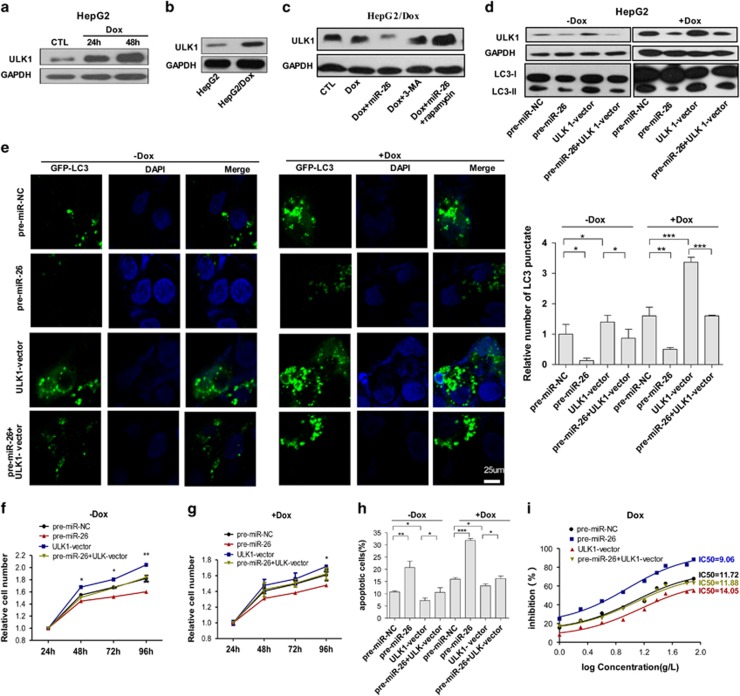
MiR-26a/b enhances the sensitivity of HCC cells to chemotherapeutic drugs and promotes HCC apoptosis by inhibiting autophagy in vitro. (a) Representative western blotting analyses of ULK1 in HepG2 cells after treatment with Dox over time. (b) Different expression levels of ULK1 in HepG2 and HepG2/Dox cells. (c) ULK1 levels in HepG2/Dox cells transfected with/without miR-26 mimics under different treatments. (d) HepG2 cells transfected with pre-miR-NC, pre-miR-26, ULK1-vector or pre-miR-26 plus ULK1-vector, treated with/without Dox. Protein levels of ULK1 and LC3 were determined. (e) Representative photographs of HepG2 cells transfected with GFP-LC3-expressing plasmids plus pre-miR-NC, pre-miR-26, ULK1-vector or pre-miR-26+ULK1-vector, treated with/without Dox. The right-hand histogram represents a quantitative analysis of GFP-LC3 punctae from 10 micrographs. (f and g) Cell viabilities of HepG2 cells under different treatments were determined using a CCK-8 assay at various time points. (h) Cell apoptosis of HepG2 cells under various treatments was analyzed using flow cytometry. (i) The sensitivities of HepG2 cells under different transfections with Dox were determined using a CCK-8 assay. *P<0.05; **P<0.01; and ***P<0.001